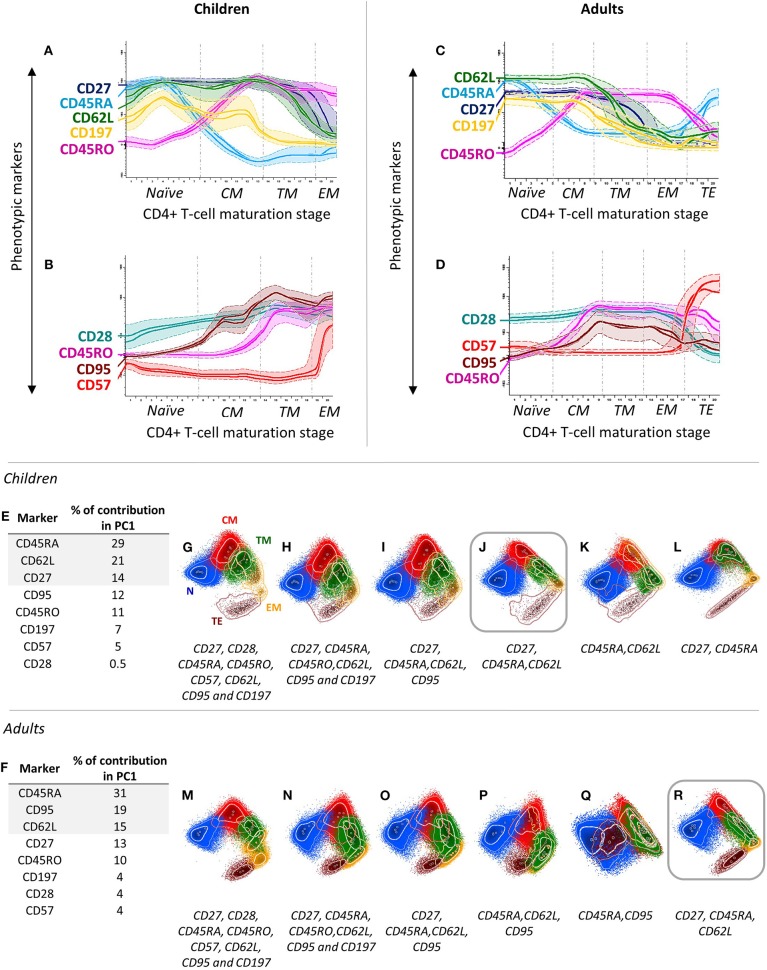
Stepwise process used for selection and evaluation of non-redundant maturation-associated markers for inclusion in the EuroFlow immune monitoring (IMM) TCD4 tube. Redundant maturation markers (i.e., CD45RO, CD95, and CD197) were identified based on analysis of blood CD4+ T cells from two healthy children (aged 2 and 9 years) (A,B) and two healthy adults (two 40-year-old donors) (C,D). In the maturation diagrams (A–D), colored (solid) lines represent the level of expression of markers per maturation stage corresponding to each donor, while dotted lines represent one standard deviation (SD). The CD4+ T-cell maturation pathway was automatically divided into 20 stages, ranging from the less mature (1) to the most mature (20) immunophenotype based on the Maturational Pathway Tool of the Infinicyt software. By combining stages with comparable immunophenotypes for CD27, CD45RA, and CD62L, the arbitrary 20 stages were reduced to five distinct maturation stages: (i) naïve (N) cells, CD27+CD45RA+CD62L+; (ii) central memory (CM), CD27+CD45RA–CD62L+; (iii) transitional memory (TM), CD27+CD45RA–CD62L–; (iv) effector memory (EM), CD27–CD45RA–CD62L±; and (v) terminal effector (TE), CD27–CD45RA+CD62L–. Additionally, a combination of eight maturation-associated markers was evaluated in PB samples from healthy children (n = 5) (E) and adults (n = 3) (F) using principal component (PC) analysis. Different combinations of these markers were tested using PC1 vs. PC2 automatic population separator (APS1) plots to select the markers providing the best resolution (separation) between the different maturation stages of CD4+ T cells (G–R). According to their percentage contribution in PC1 (E,F), markers were sequentially removed from APS1 plots (from lower to higher), as indicated (G–R), to determine the minimum combination of markers required for reliable identification of all five major stages of maturation of CD4+ T cells (please see above: N, CM, TM, EM, and TE cells). APS1 plots with the best resolution power are highlighted with squares. In all PC1-vs.-PC2 plots, solid circles represent median values for the parameters evaluated; inner (dotted) and outer (solid) lines represent the first and second SDs for each population identified, color-coded as follows: N, blue; CM, red; TM, green; EM, yellow; and TE, brown, CD4+ T cells.